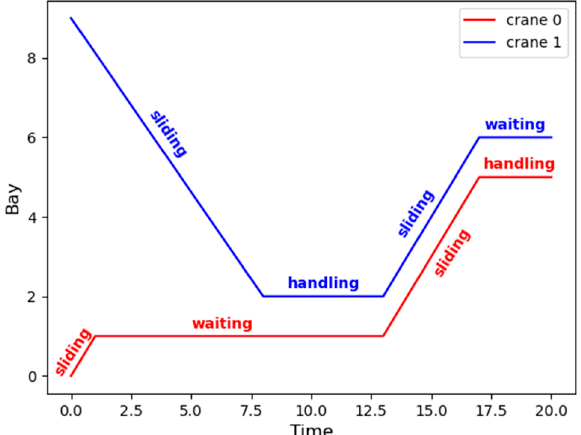
Figure 1. Spatial-temporal graphic of twin yard cranes operational plan. Table 1. An example of initial task.